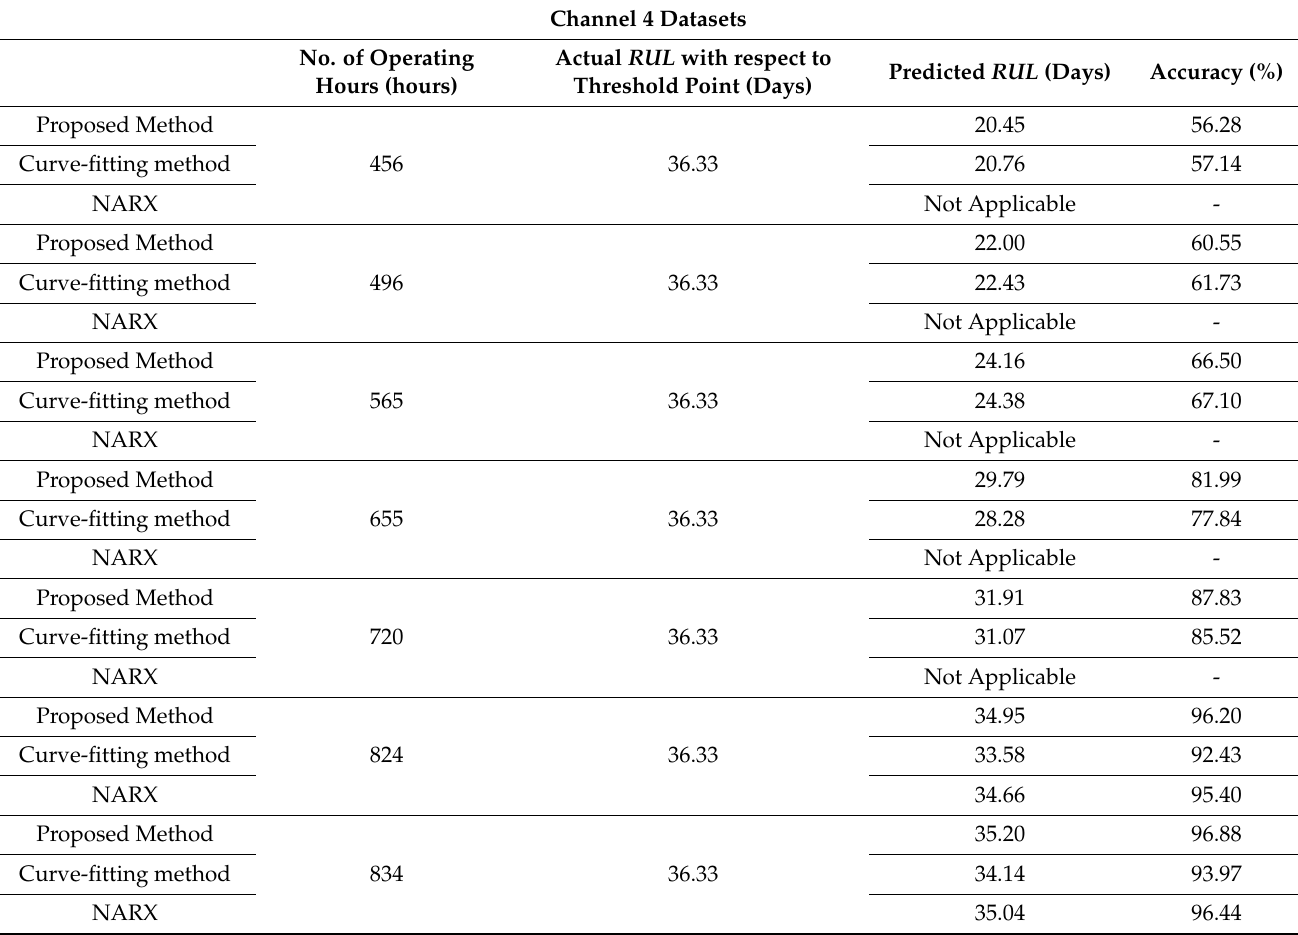
Table 4. RUL predicted by developed and other existing models for channel